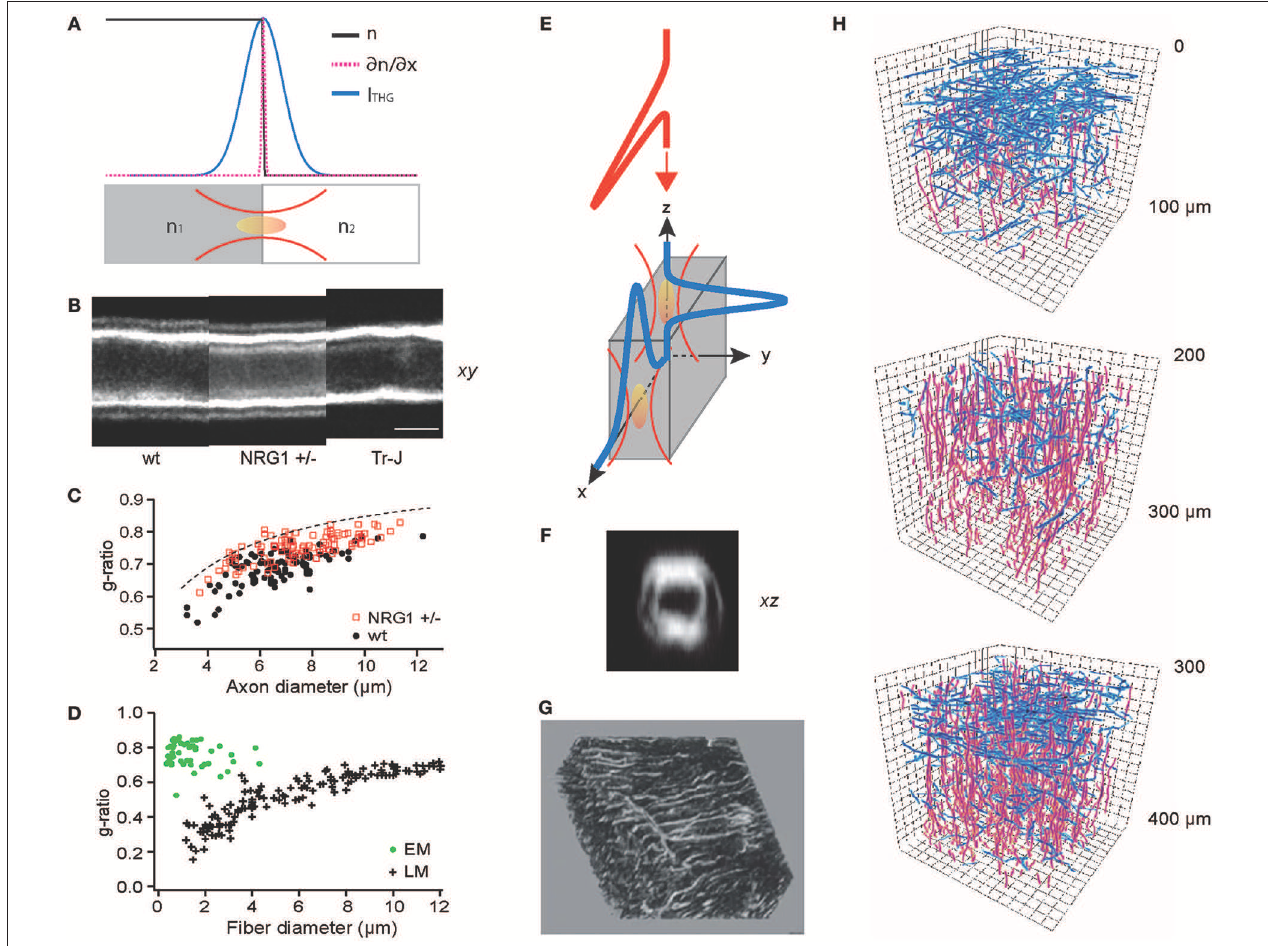
FIGURE 2 | THG for optical metrology and 3D reconstruction of connected meshworks. (A) THG as an optical edge detection, as illustrated in Equation (8). (B) THG images of the sciatic nerves of wild-type (WT), haploinsufficient NRG1 knockout (NRG1 + /–), and trembler mutant (Tr-J) mice. (C) The g-ratios evaluated for WT and NRG1 + /– mice ( N = 4 each) (reproduced from Lim et al., 2014). (D) The g-ratio evaluation by electron (EM) and light microscopy (LM) (redrawn from Waxman and Bennett, 1972 ). (E) Surfaces perpendicular or parallel to the optic axis can be detected by THG. (F) An axial section of the myelinated sciatic nerve showing the entire circumference (reproduced from Lim et al., 2014). (G) A 3D rendering of the lacuno-canalicular network (LCN) visualized by THG (adapted from Genthial et al., 2017). (H) Traces of cortical myelin imaged by THG, horizontal (blue) and vertical (red) fibers in three depths (approximately in layers 1, 2/3, and 4, respectively), showing the distinct abundance of horizontal fibers in layers 1 and 4 (redrawn from Redlich and Lim,